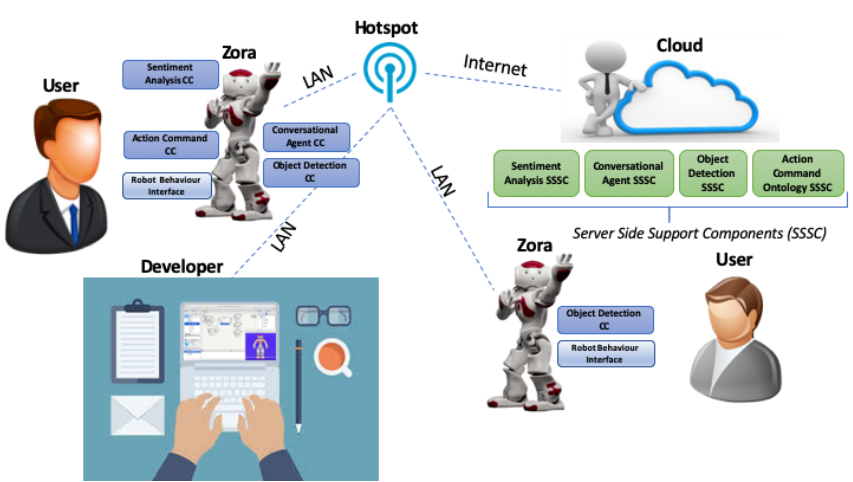
Figure 1. Proposed high-level architectural